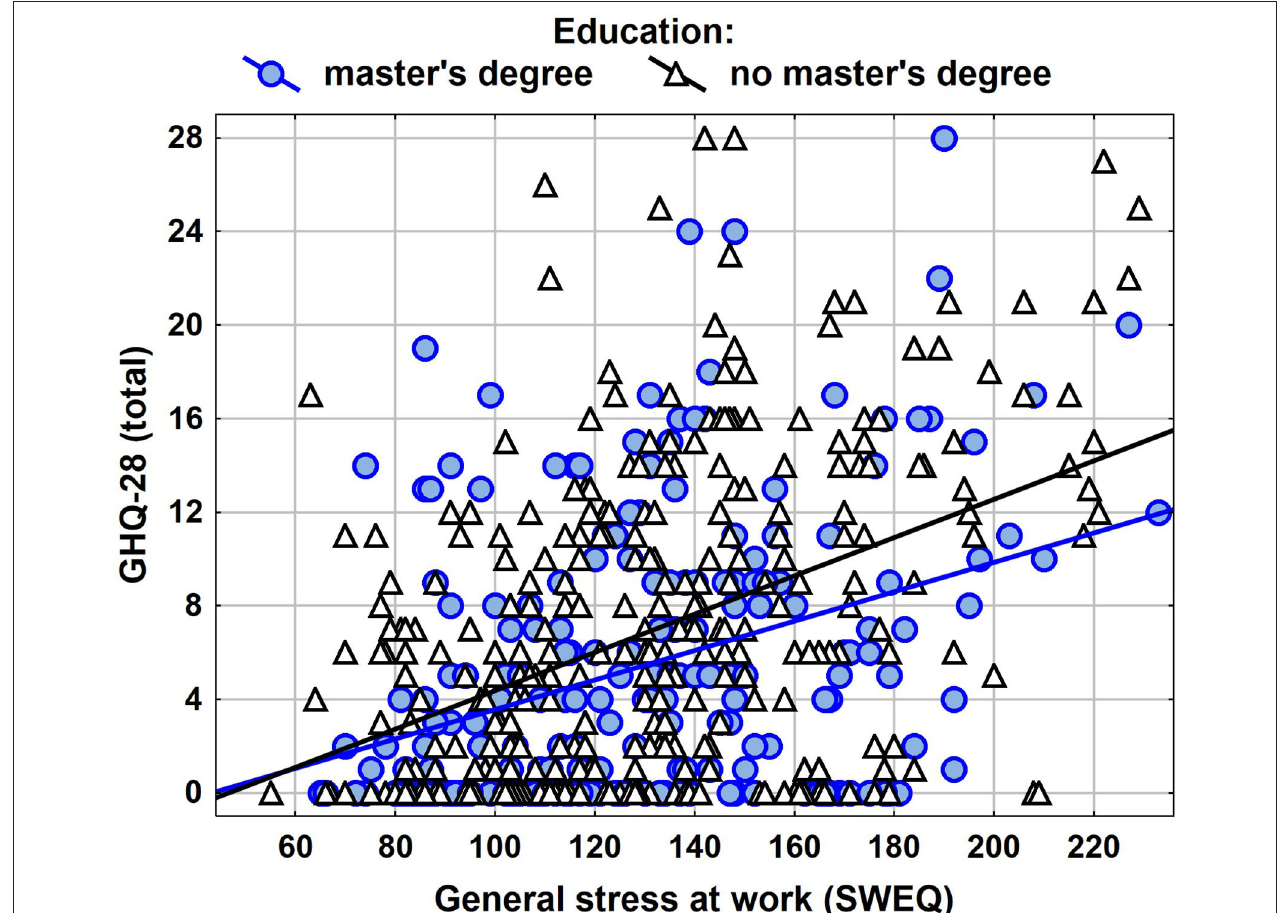
FIGURE 1 | NImpact of SWEQ general measure in interaction with education level on GHQ-28